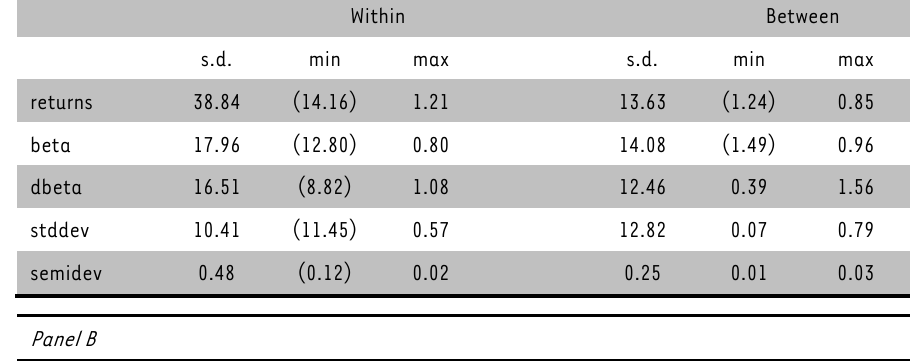
TABLE A-2: Descriptive statistics (monthly returns) Panel